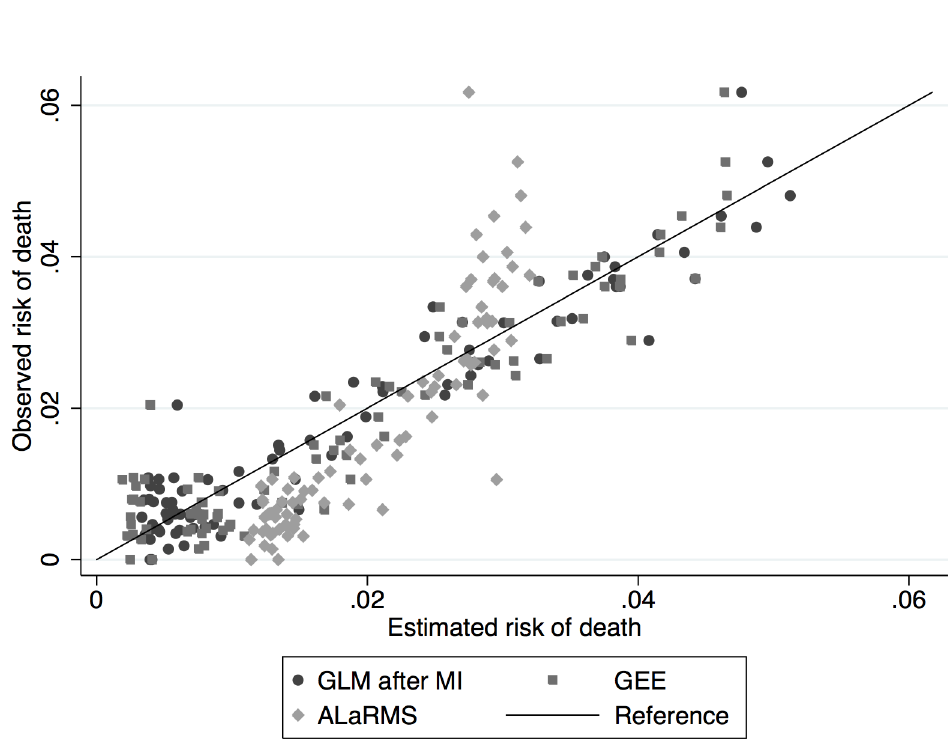
Fig 5. Model calibration according to ‘ Age ’ . Expected vs. Observed risk of death for GEE, GLM, ALaRMS.